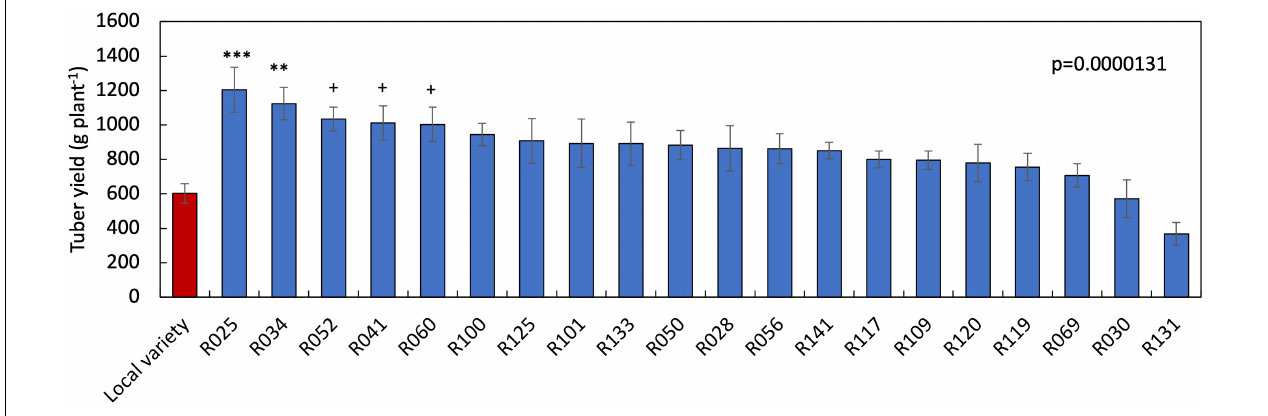
FIGURE 3 | Varietal differences in tuber yield in 21 white Guinea yam genotypes at low nutrients soil conditions. Data are the average of values obtained during a 2-year field experiment. Statistical significance was determined by Dunnett’s test. ***( p < 0.001), **( p < 0.01) and + ( p < 0.1) when compared with the local variety. Bars indicate standard error ( n = 12). R means TDr1302 as IITA yam breeding